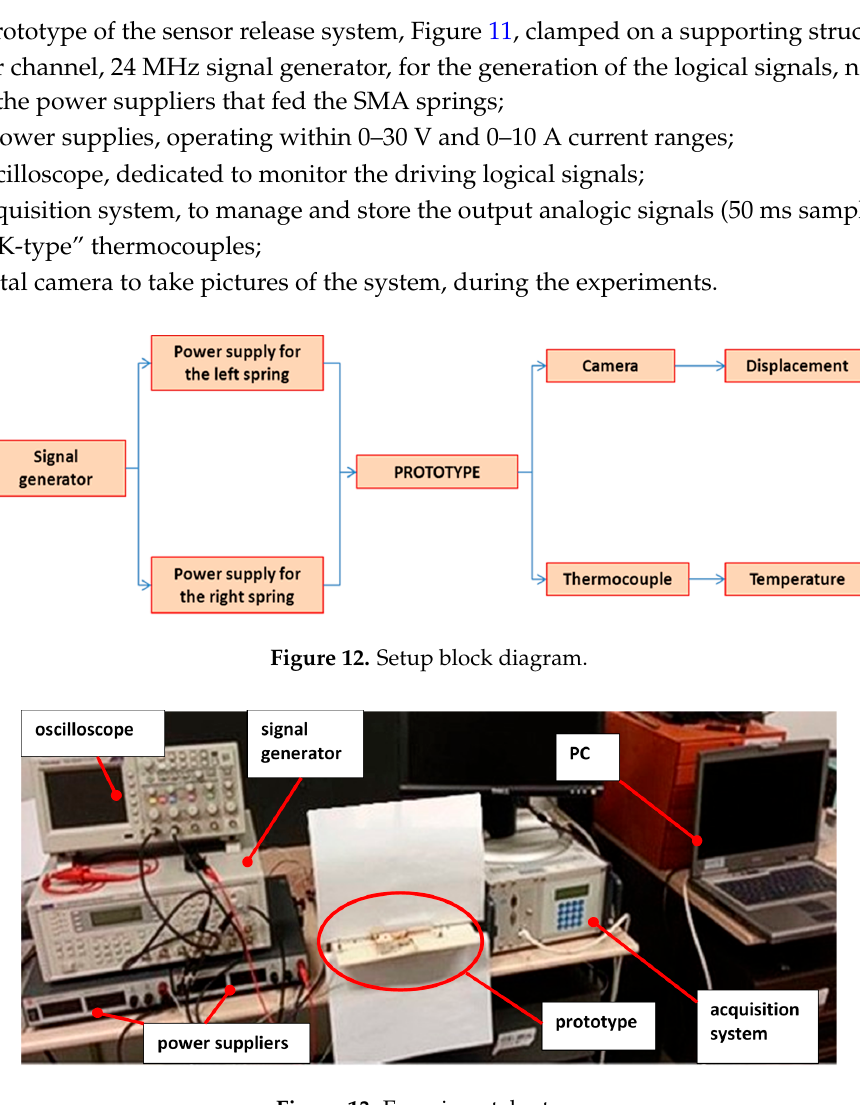
Figure 13. Experimental setup.